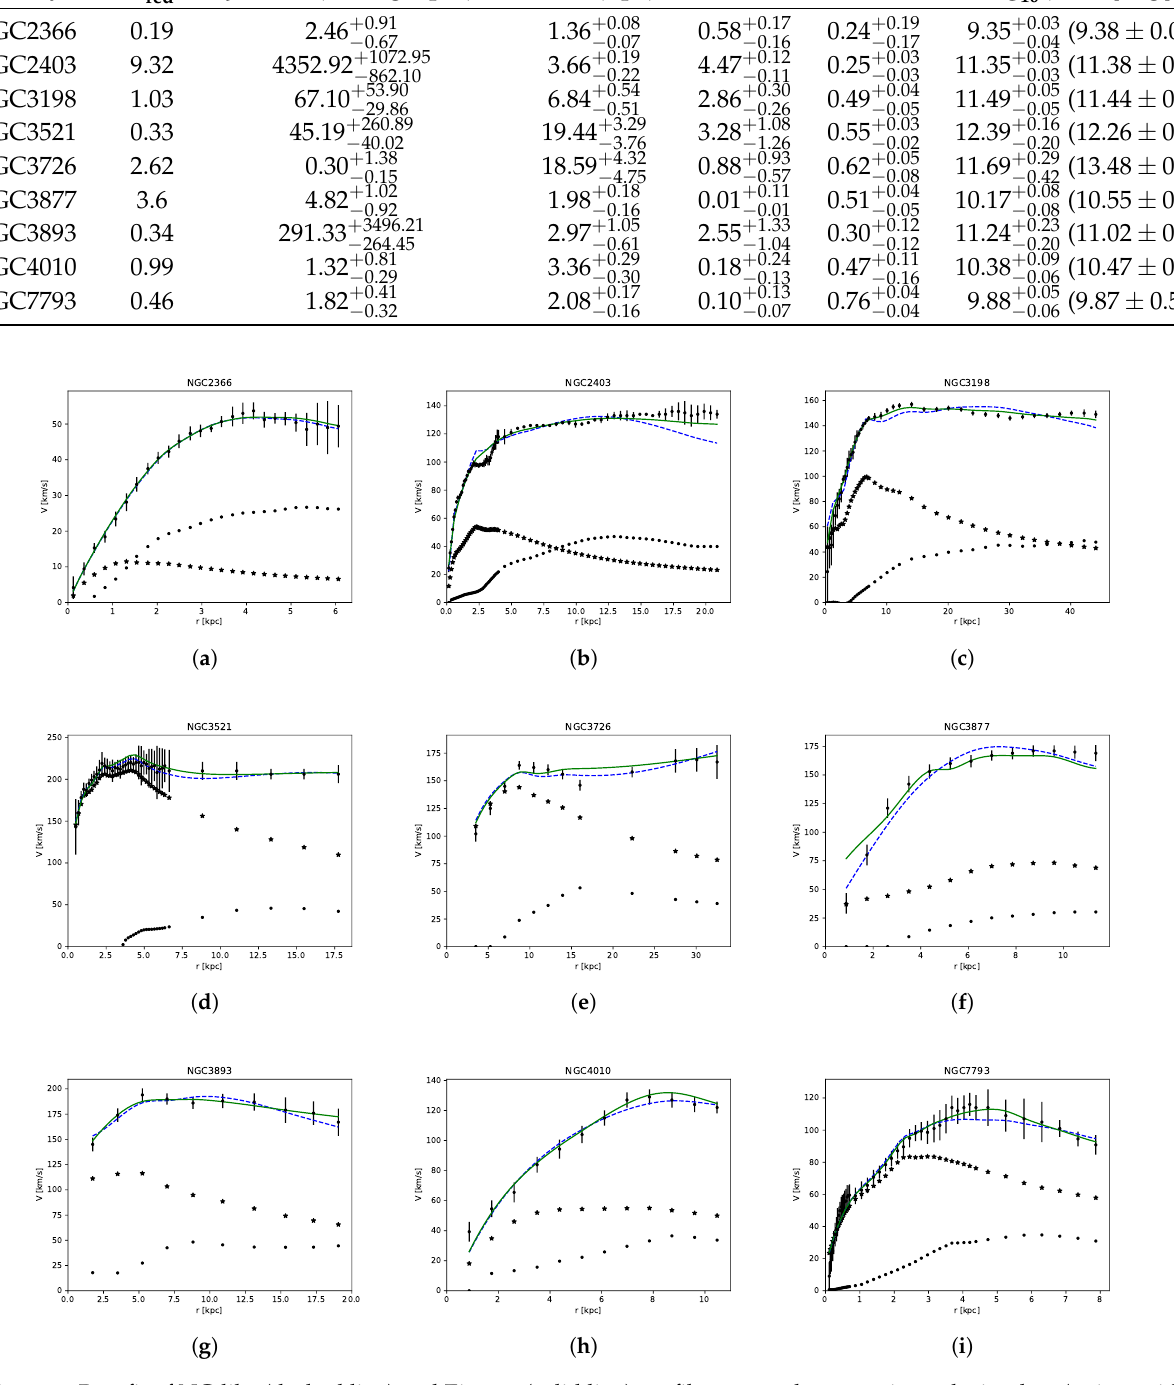
Figure 1. Best fit of NC-like (dashed line) and Einasto (solid line) profiles over galaxy rotation velocity data (points with error bars), disk velocity (star markers), and gas velocity (circle markers). The total rotation velocity is obtained from Equation